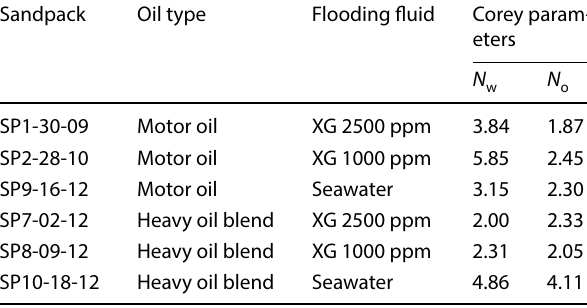
Table 8 Corey correlation relative permeability parameters matched to experimental data Sandpack Oil